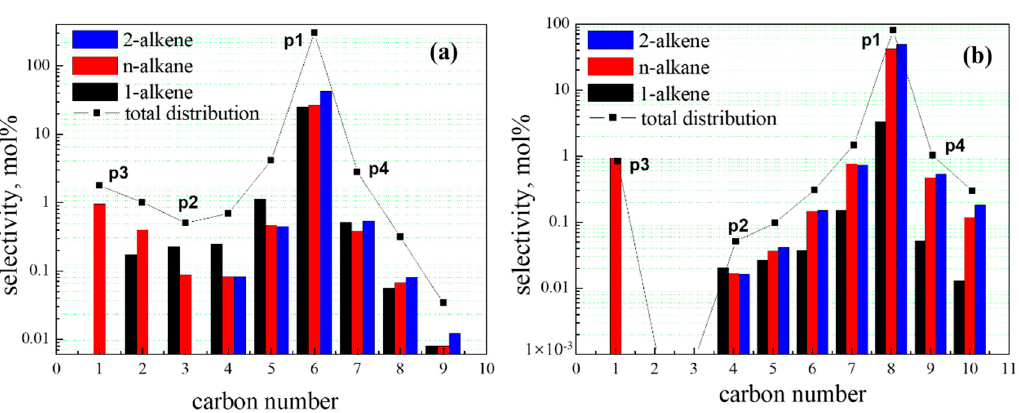
Figure 3. The detailed product distribution of heavier 1-alkene reaction (T = 533 K, p = 0.8 MPa). ( a ) C 6 H 12 in H 2 atmosphere, H 2 /C 6 H 12 = 2.1. ( b ) C 8 H 16 in H 2 atmosphere, H 2 /C 8 H 16 = 2.1.